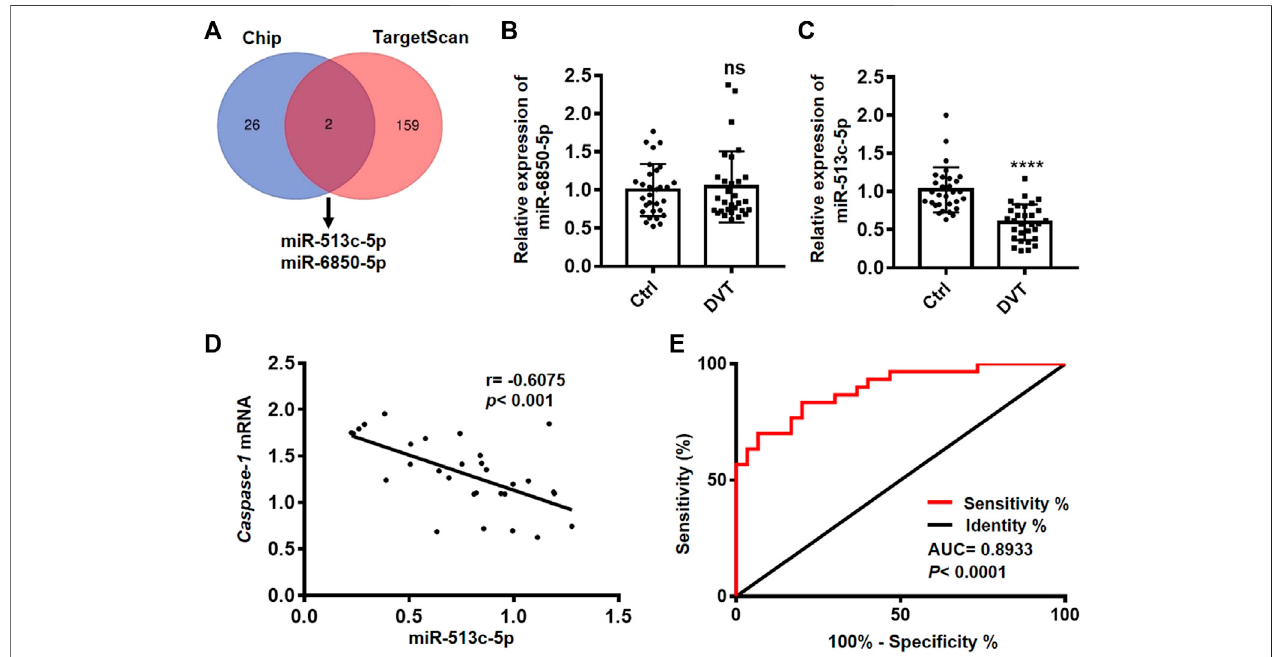
FIGURE2| miR-513c-5p isdown-regulatedinDVTpatientsandnegativelycorrelatedwithcaspase-1. (A) TheVenndiagramshowsmiR-513c-5pandmiR-6850- 5ppredictedbyTargetScanandChip. (B) TheexpressionlevelofmiR-6850-5pinPBMCsfrom30DVTpatientsand30controlswasmeasured byqRT-PCR.nsmeans no statistical difference. (C) The expression level of miR-513c-5p in PBMCs from 30 DVT patients and 30 controls was measured by qRT-PCR. (D) The correlation between miR-513c-5p and caspase-1 was analyzed using Pearson correction analysis ( n = 30). (E) Diagnostic value of miR-513c-5p for DVT was evaluated by ROC curve. **** p <